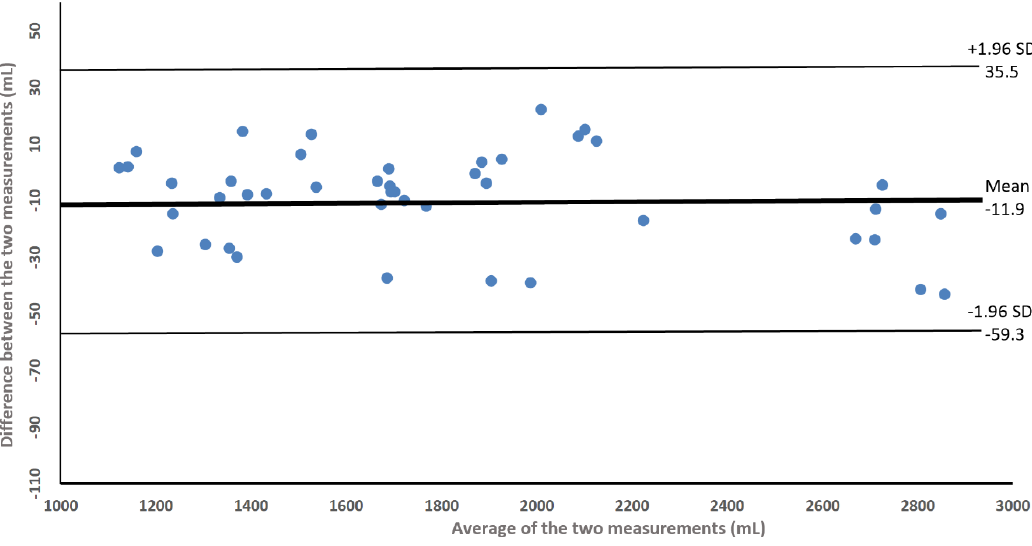
Figure 3. Bland–Altman plot showing the limits of agreement for the test–retest data on arm Figure 3. Bland – Altman plot showing the limits of agreement for the test – retest data on arm volumes.